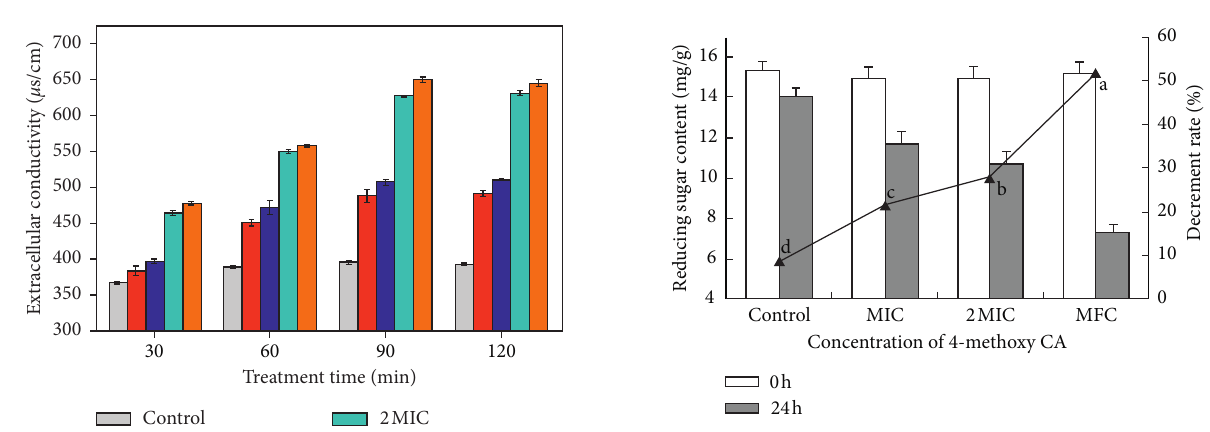
Figure 5: Effect of 4-methoxy CA on reducing sugar content of P. digitatum mycelia. Values are mean ( n � 3) ±